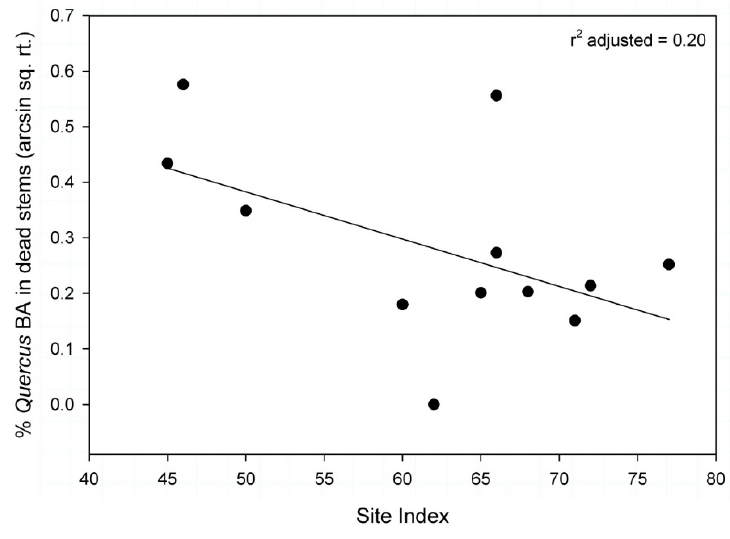
Figure 4. % Quercus BA in Dead Stems (arcsin square root) by Site Index ; % Quercus BA in Dead Stems = 0.8086 + − 0.0085 × Site Index